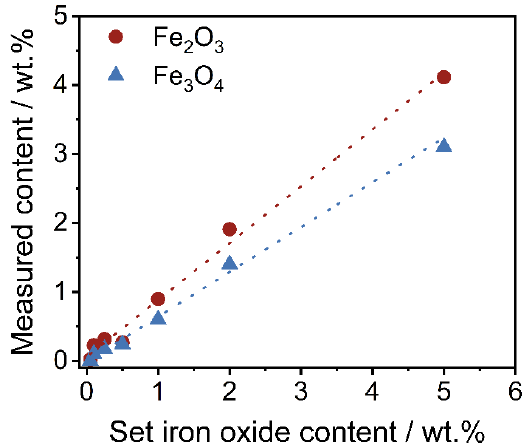
Figure 6. Measured iron oxide content in regard to the set iron oxide content of both formulations.